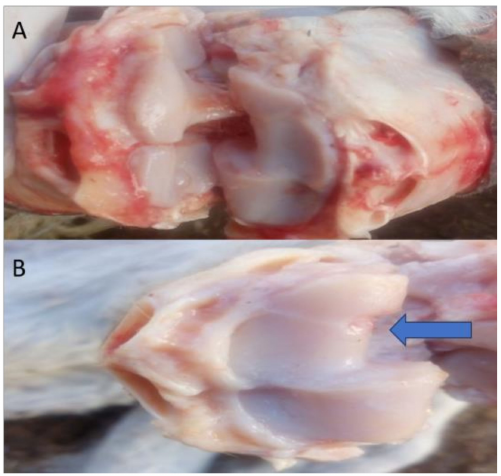
Figure 7. Representative images of the macroscopic observation for the distal articular surface of the radius. ( A ) Represents the right radiocarpal joint, while ( B ) Represents the left radiocarpal joint, showing erosions at the distal articular surface of the radius after the 7th month (blue